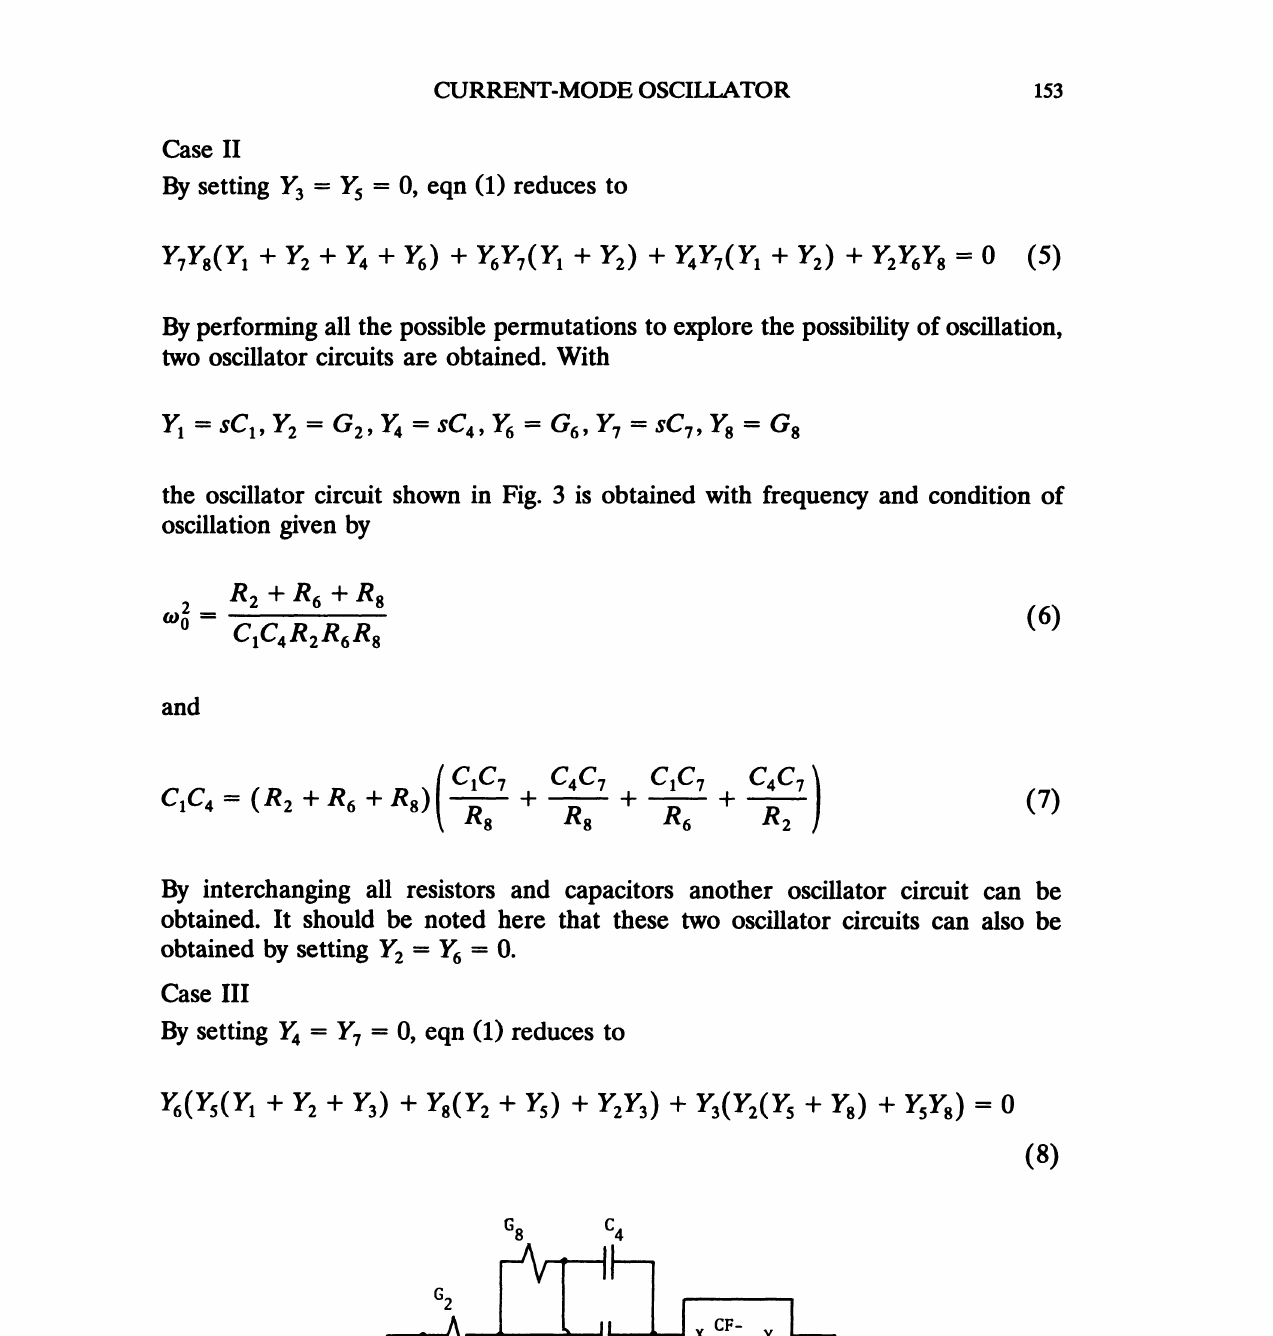
FIGURE 3 A proposed unity-gain current-follower based oscillator circuit derived from Fig.